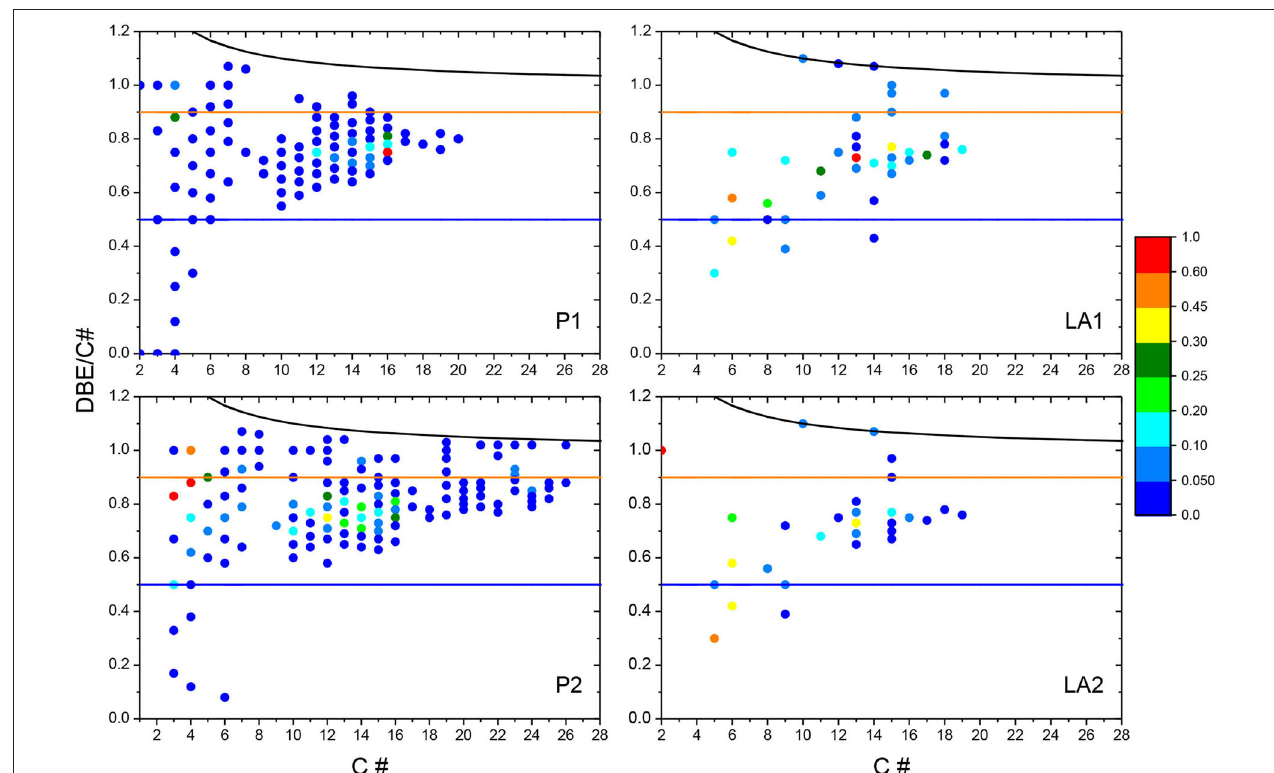
FIGURE 5 | Plot of DBE/C# (see Equation 1) as a function of the carbon number (C#) for the hydrocarbons and a few carbon clusters, which have been identified with AROMA on samples P1, P2, LA1, and LA2. The corresponding mass spectra for the three first samples are shown in Figure 4 . The colored scale refers to the normalized intensity on the most intense peaks in the spectra. Below DBE/C# = 0.5 the species are considered as aliphatic and above as containing aromatic cycles (Koch and Dittmar, 2006). They remain planar below DBE/C# = 0.9 (Hsu et al., 2011). Above this value, they are classified as HC clusters. The upper black line corresponds to pure carbon